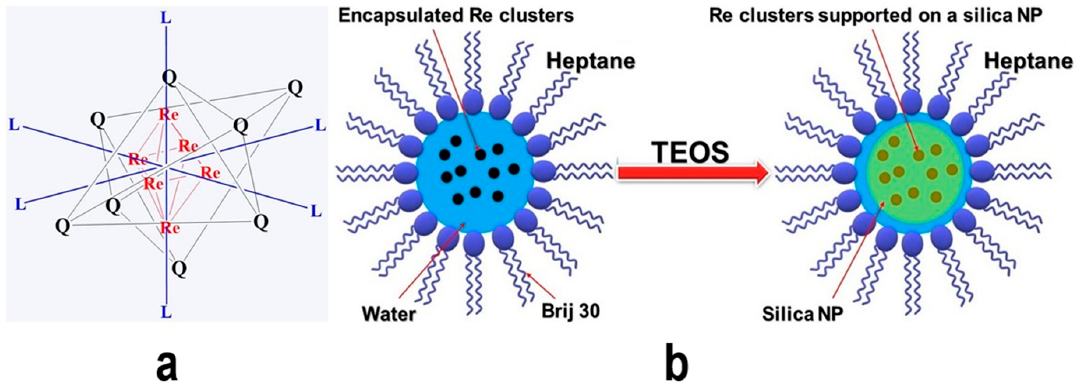
Figure 4. A schematic representation of ( a ) Re 6 Q 8 L 6 cluster unit, and ( b ) the process of Re 6 Q 8 L 6 @SiO 2 NPs encapsulation (as reported by Aubert et al. [81]), redrawn by the authors from the reference.